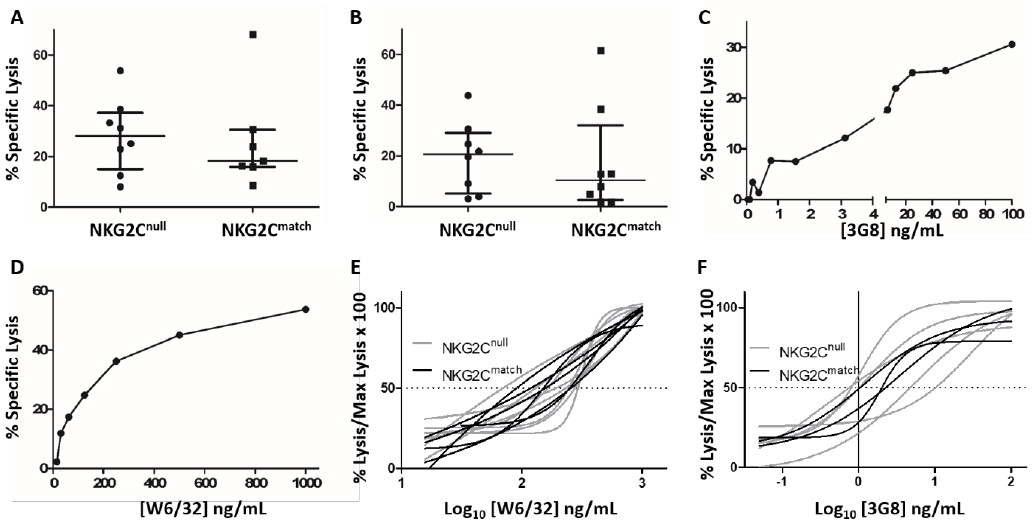
Figure 4. Comparison of cytotoxicity triggered through CD16 for NKG2C null and matched control groups. After overnight recovery, cryopreserved PBMC were incubated with 51 Cr-labeled ( A ) P815 cells and anti-CD16 (3G8 mAb) or with ( B ) anti-HLA class I-coated C1R-B27 cells at an E:T 50:1. The probability of a significant difference in median lysis between groups in either assay was assessed by the Mann-Whitney U test. Representative titrations of PBMC incubated with ( C ) P815 cells and 3G8 mAb at concentrations ranging from 0.05 to 100 ng/mL and ( D ) anti-HLA class I-coated C1R-B27 cells at concentrations ranging from 1.7 to 100 ng/mL in 5 h cytotoxicity assays. EC 50 values were estimated for each subject from Ab concentrations yielding half-maximal target cell lysis. Titration curves normalized to 100 for maximum observed killing with each subject tested are shown for ( E ) W6/32 and ( F ) 3G8.